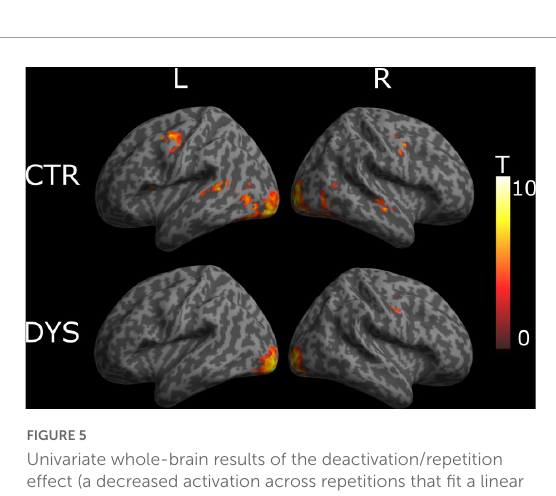
activation clusters is presented in Supplementary Tables 1 , 2 for controls and dyslexic readers, respectively. The two-sample t -test did not show any significant differences between the two groups (at a voxel-wise statistical threshold of p < 0.001